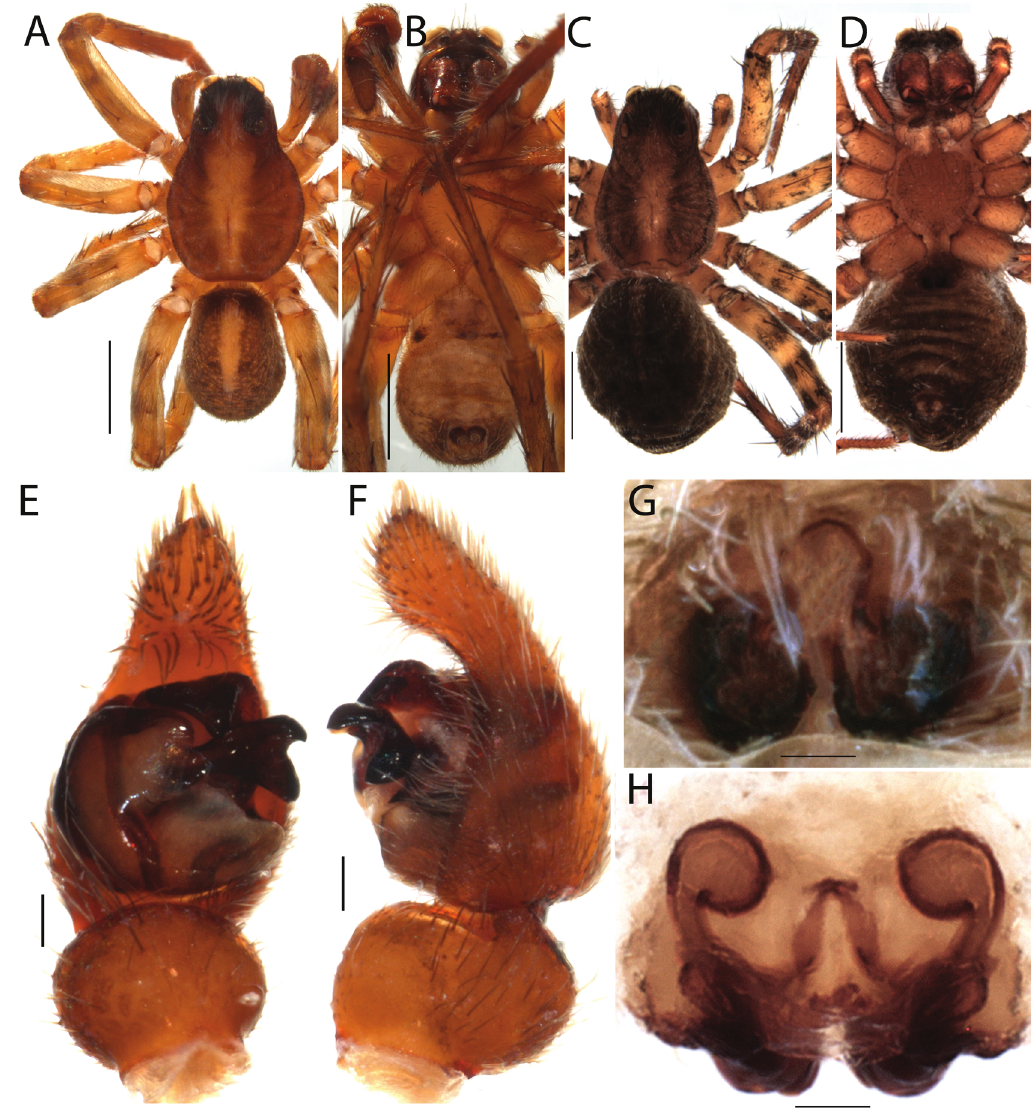
Figure 13. A. booderee sp. n., male holotype (AM KS128069), female paratype (AM KS63500): A , male habitus, dorsal view; B , male habitus, ventral view; C , female habitus, dorsal view; D , female habitus, ventral view; E, male pedipalp, ventral view; F , male pedipalp, retrolateral view; G , epigyne, ventral view; H , epigyne, dorsal view. Scale bars: habitus 1.0 mm; pedipalp, epigyne 0.1